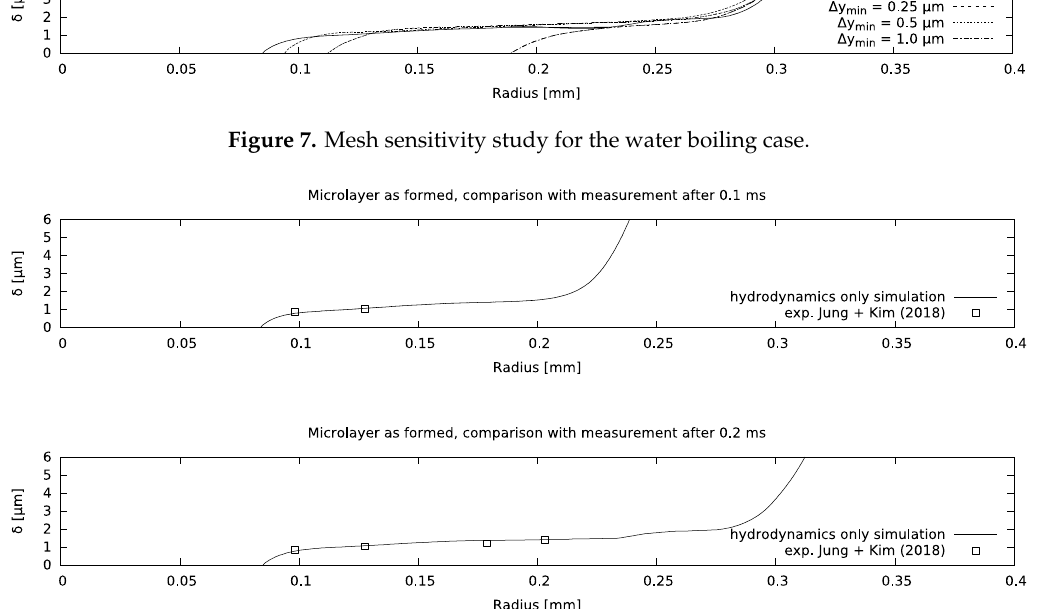
Figure 8. Comparison between modelled and measured microlayer thicknesses for the water boiling case.